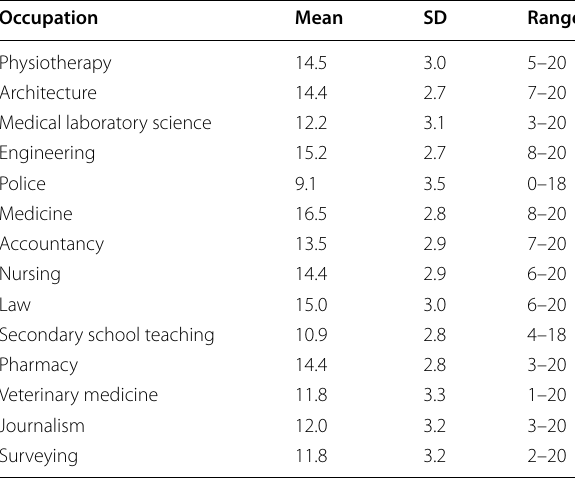
Table 2 Overall perception of occupational prestige